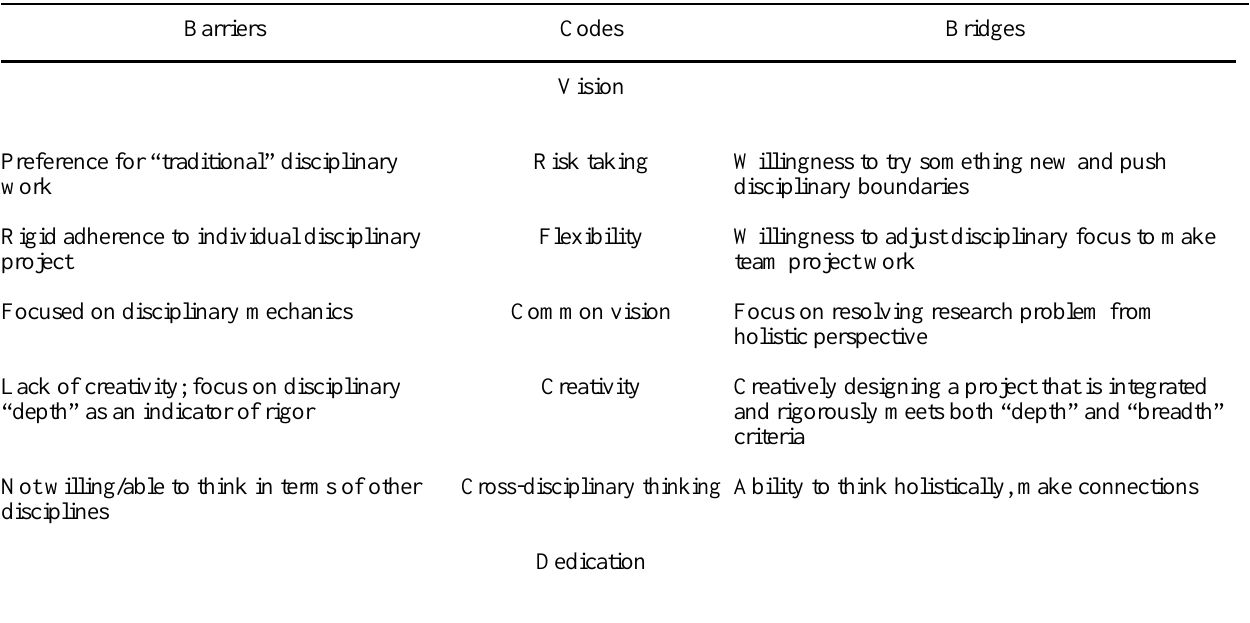
Table 3 . Individual bridges and barriers to integrated interdisciplinary